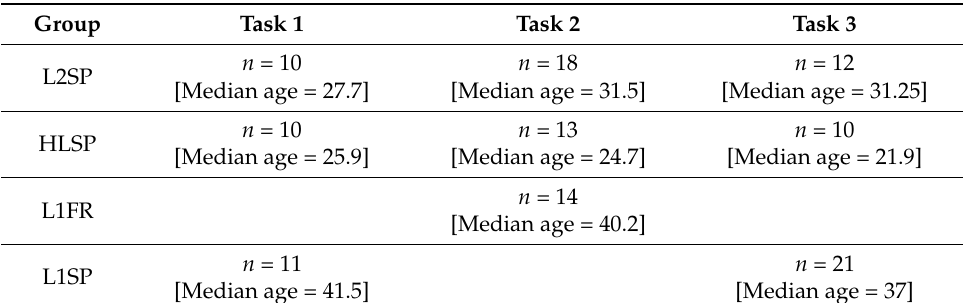
Table 1. Participant information for each task.